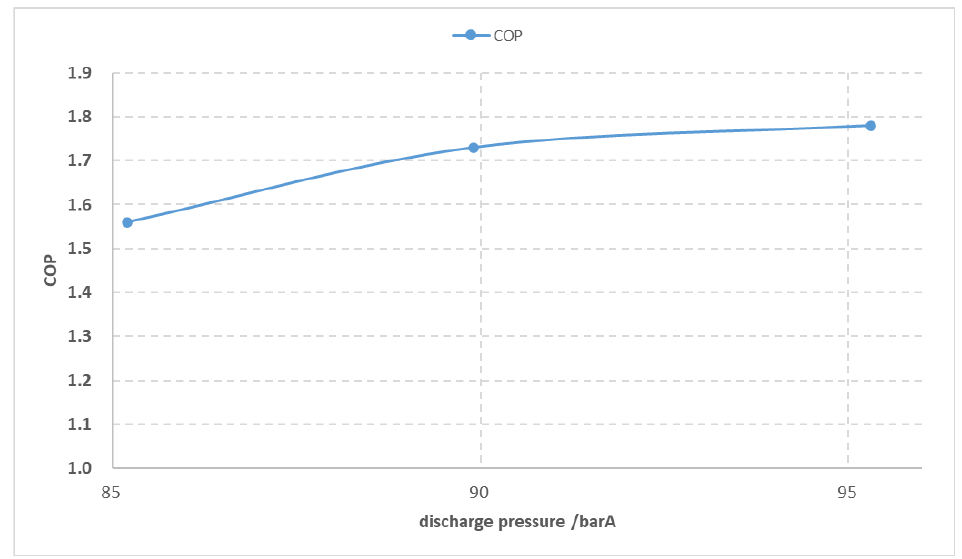
Figure 11. COP along with different discharge pressure in − 15 °C.